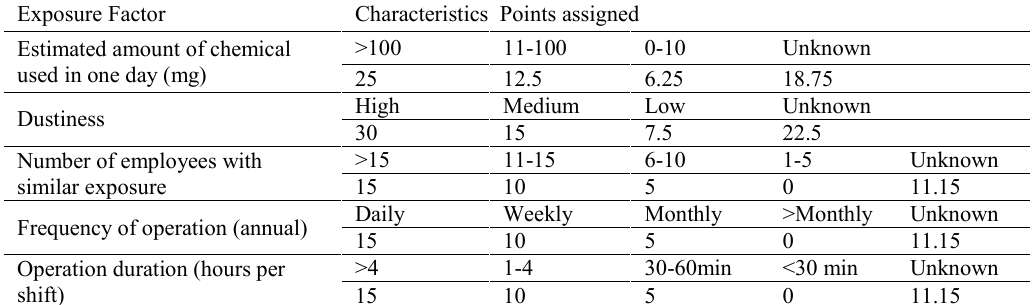
Table 3. Exposure probability factors of Control Banding Nanotool Exposure